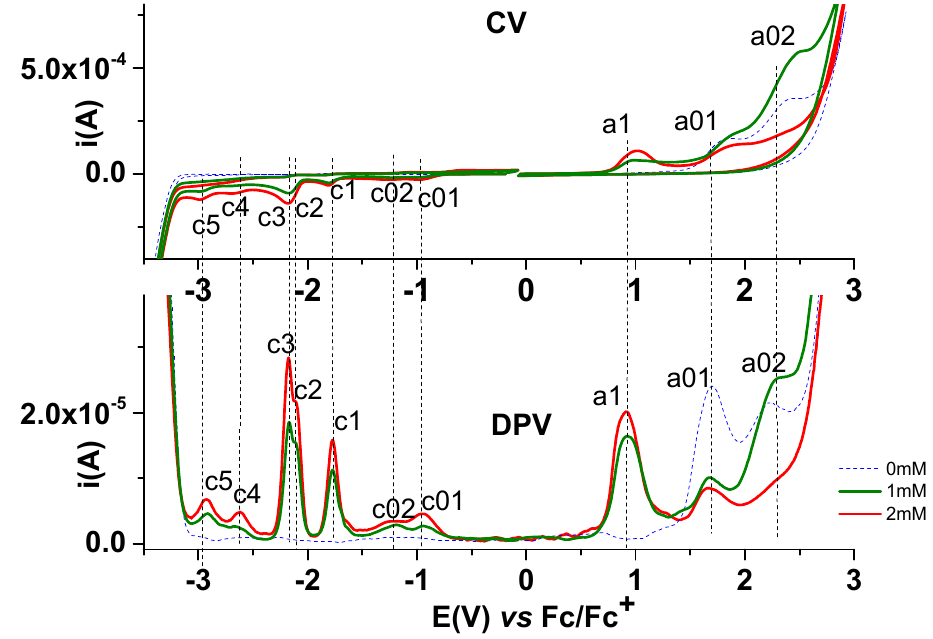
Figure 2. DPV (bellow) and CV (above) curves for L at di ff erent concentrations (0, 1 and 2 mM); absolute values of DPV currents are shown.